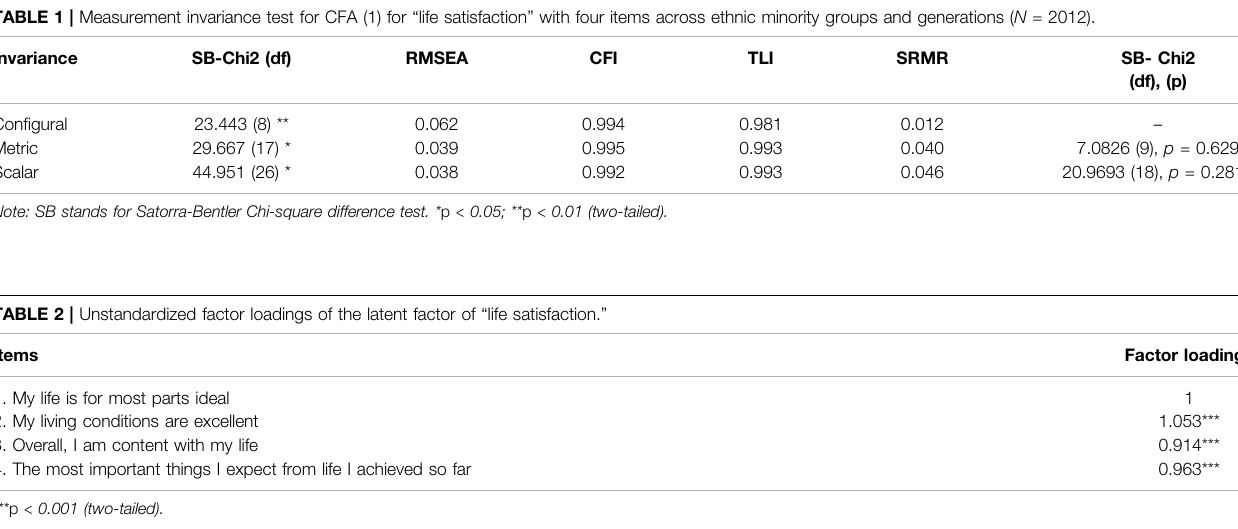
TABLE 3 | Structural invariance test between 1 st generation Turkish minority ( n (cid:1) 624), 2 nd generation Turkish minority ( n (cid:1) 350), 1 st generation Moroccan minority ( n (cid:1) 620) and 2 nd generation Moroccan minority ( n (cid:1) 351) ( N (cid:1) 2012). SB-Chi2 (df) RMSEA SB Chi2